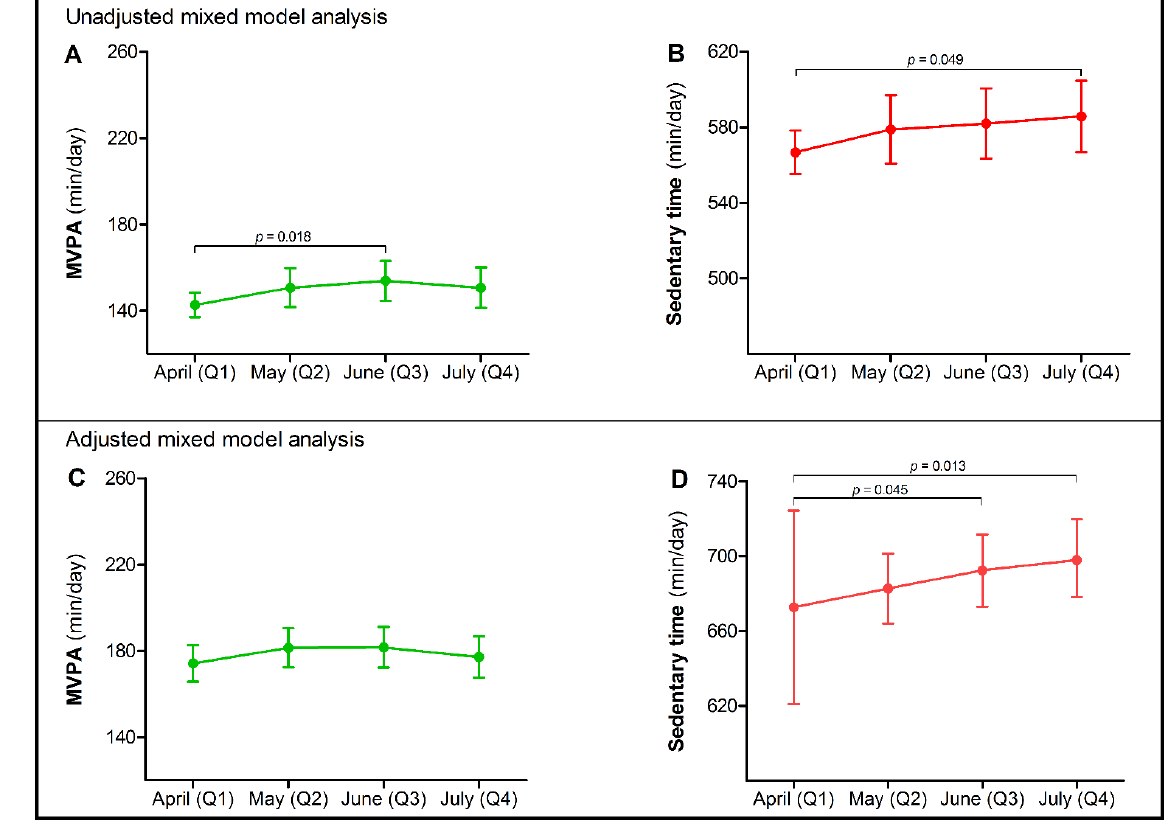
Figure 2. Moderate-to-vigorous physical activity (MVPA) and sedentary time with 95% confidence intervals (CIs) in Dutch chronic cardiovascular disease (CVD) patients at four different timepoints (Q1 (reference category); Q2; Q3; Q4) during the COVID-19 lockdown in 2020. In the unadjusted mixed model analysis, a small temporary increase was found in time spent performing MVPA after 8 weeks [ Δ+ 11.2 (95% CI 1.9; 20.5) min/day] ( A ), while a time-dependent increase in sedentary time [ Δ+ 19.0 (95% CI 0.1; 37.8) min/day] was observed after 12 weeks of lockdown ( B ). In the final multivariate mixed model analysis, adjusted for confounding factors, MVPA did not change across time ( C ), but a progressive increase in sedentary time was found among chronic CVD patients during the COVID-19 lockdown after 8 [ Δ+ 19.7 (95% CI 0.4; 39.0) min/day] and 12 weeks [ Δ+ 25.2 (95% CI 5.4; 47.1) min/day] ( D ).